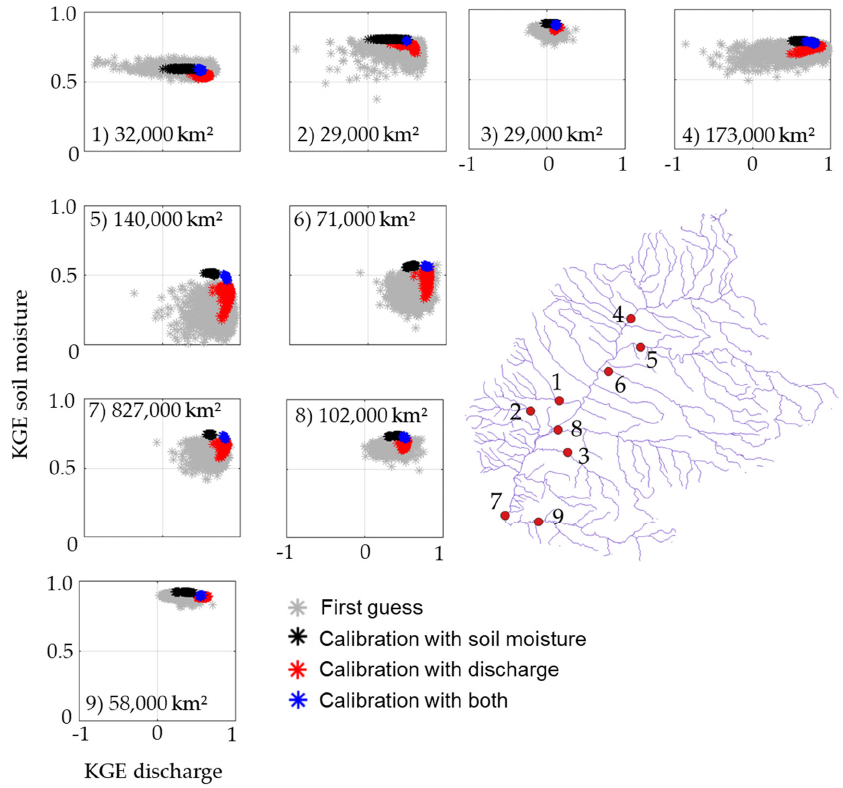
Figure 5. Soil moisture and discharge KGE values for initial and optimized solutions at nine selected gauge locations when calibrated with 136 river gauges (see the locations of all 136 gauges in Figure 2). The upstream drainage area (km 2 ) for each gauge is also presented. Each set of points refer to one calibration scenario (with soil moisture, discharge, and both).